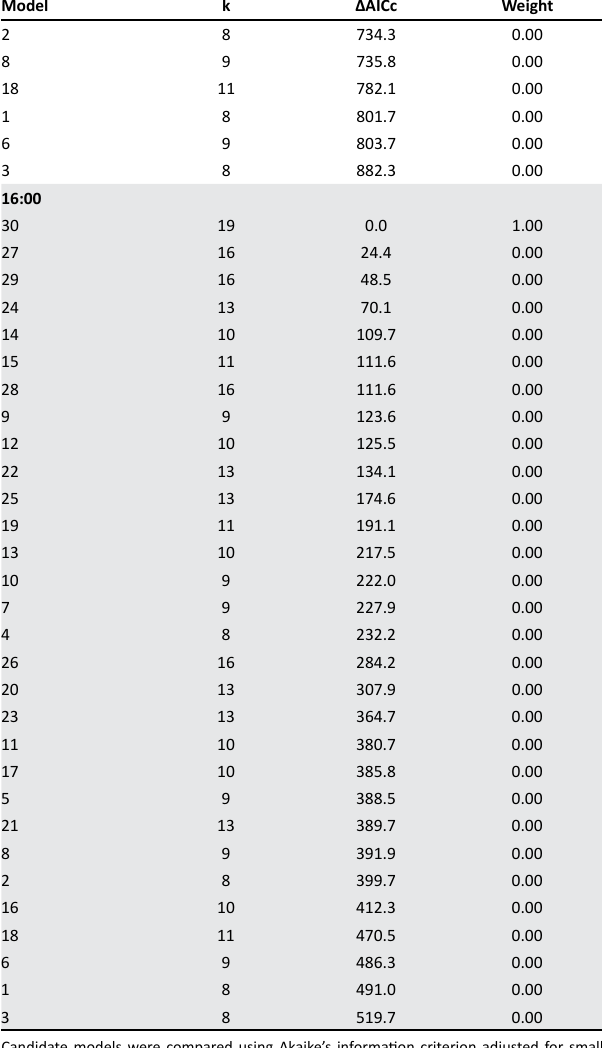
TABLE 2 (Continues...): Model selection results for elephant resource selection at a daily scale in Addo Elephant National Park, South Africa. Daily selection was considered in the morning (06:00), midday (12:00) and afternoon (16:00) to reflect within-day variation in selection